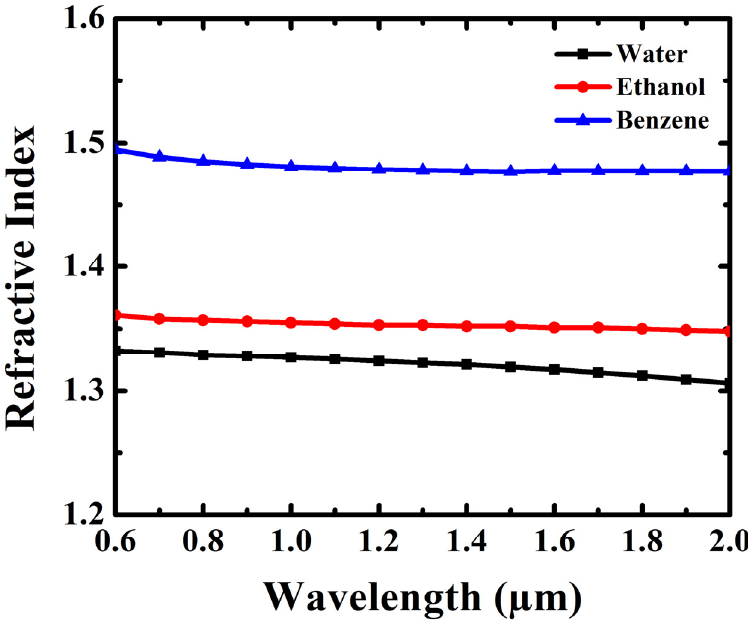
Figure 2. Refractive index of liquid analytes: water, ethanol and benzene, at 0.6–2.0 μ m operating wavelengths.